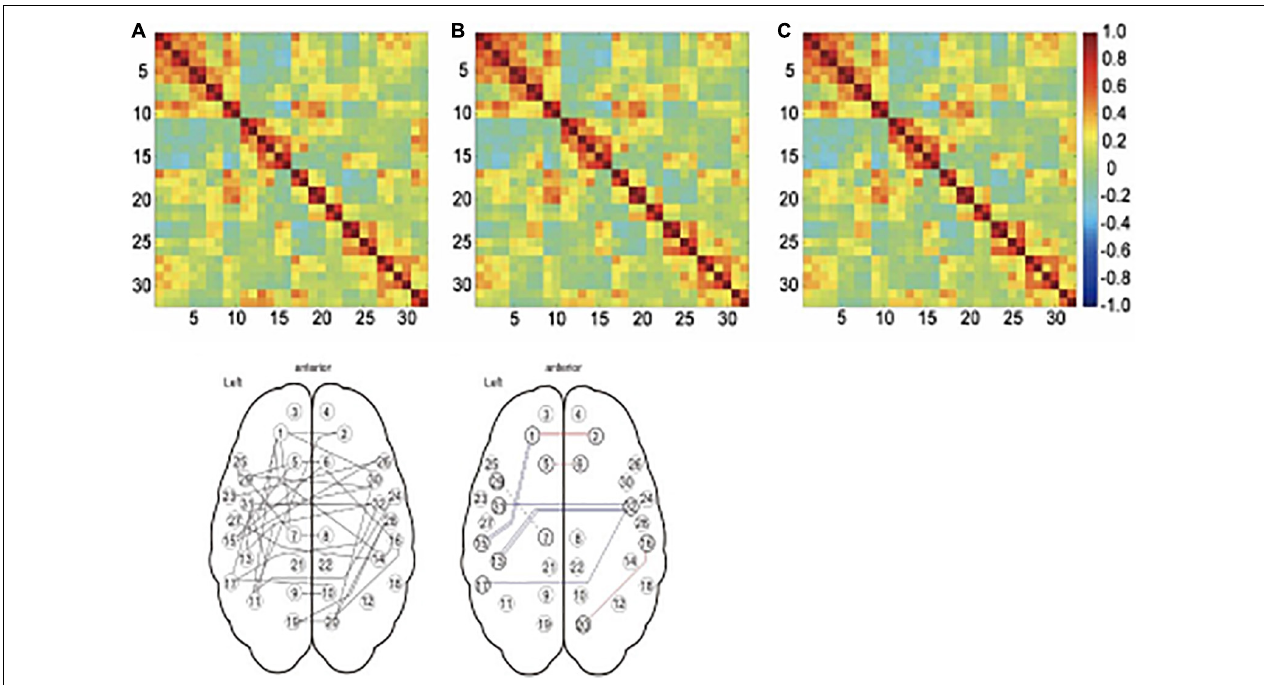
FIGURE 2 | Effect of physiological noise regressors on connectivity. The top panel shows the connectivity matrices for 36 networks, including the default mode network and related brain regions. The color of each cell reflects the correlation coefficient, with red representing strong positive correlations, green representing no correlation, and blue representing strong negative correlations. The time series used to produce the matrix in (A) were not corrected for physiological noise, in (B) , the time series were corrected for cardiac noise, and in (C) , the time series were corrected for cardiac noise and respiratory noise. While these matrices do not look very different at first glance, there were significant differences in some of the connections as shown in D. Panel E illustrates which models differed in post hoc t-test between the models. The color of the line indicates the sign of the change, with red lines showing increased connectivity strength and blue lines showing decreased connectivity strength. A double line shows a significant difference between the uncorrected model and both of the models with corrected time series (panel A vs B and C ), while a single unbroken line indicates the difference between the uncorrected model and model corrected for cardiac noise (panel A vs B ) and a single broken line indicates the difference between the uncorrected model and the model corrected for both types of noise (panel A vs C ). Reproduced from Yoshikawa et al.